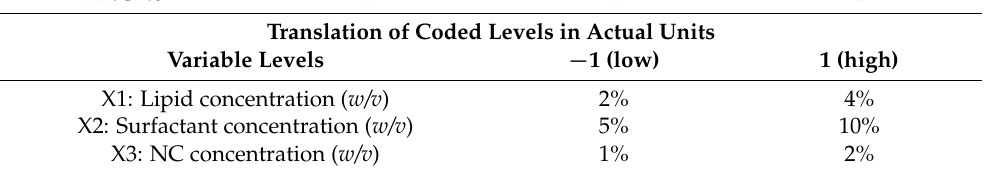
Translation of Coded Levels in Actual Units Variable